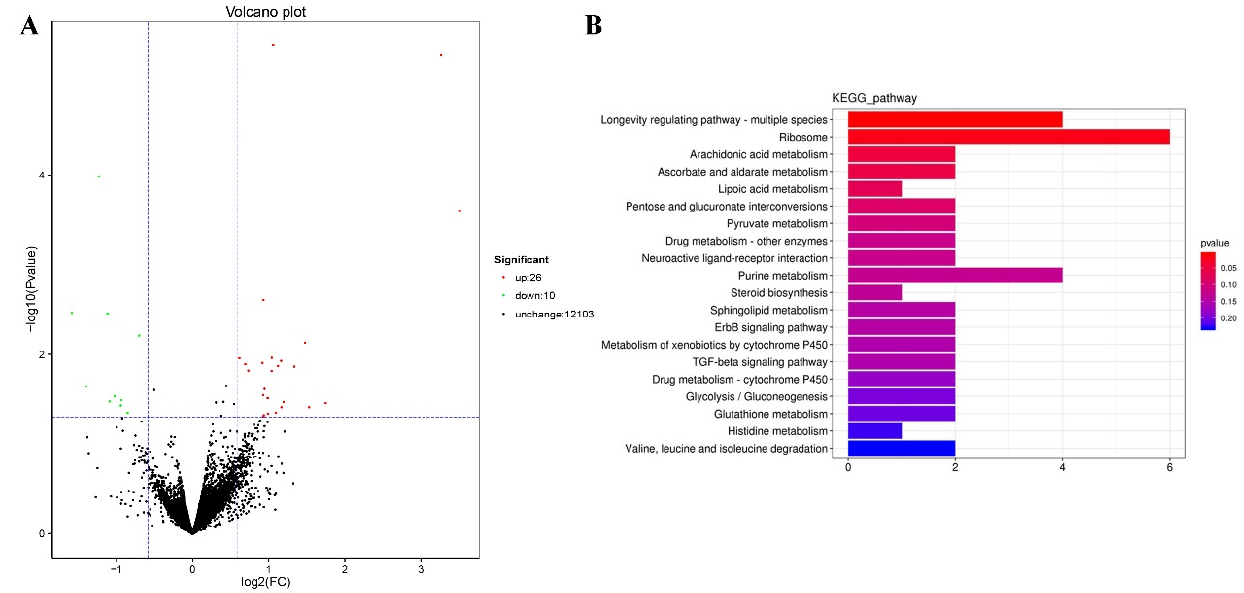
Figure 5. Modulated pathways in TG treated in C. elegans . ( A ) A total of 26 genes were upregulated and 10 genes were downregulated following the TG treatment (FDR < 0.05 and fold change > 1.5). ( B ) The KEGG analysis of differentially expressed genes in TG-treated C. elegans .